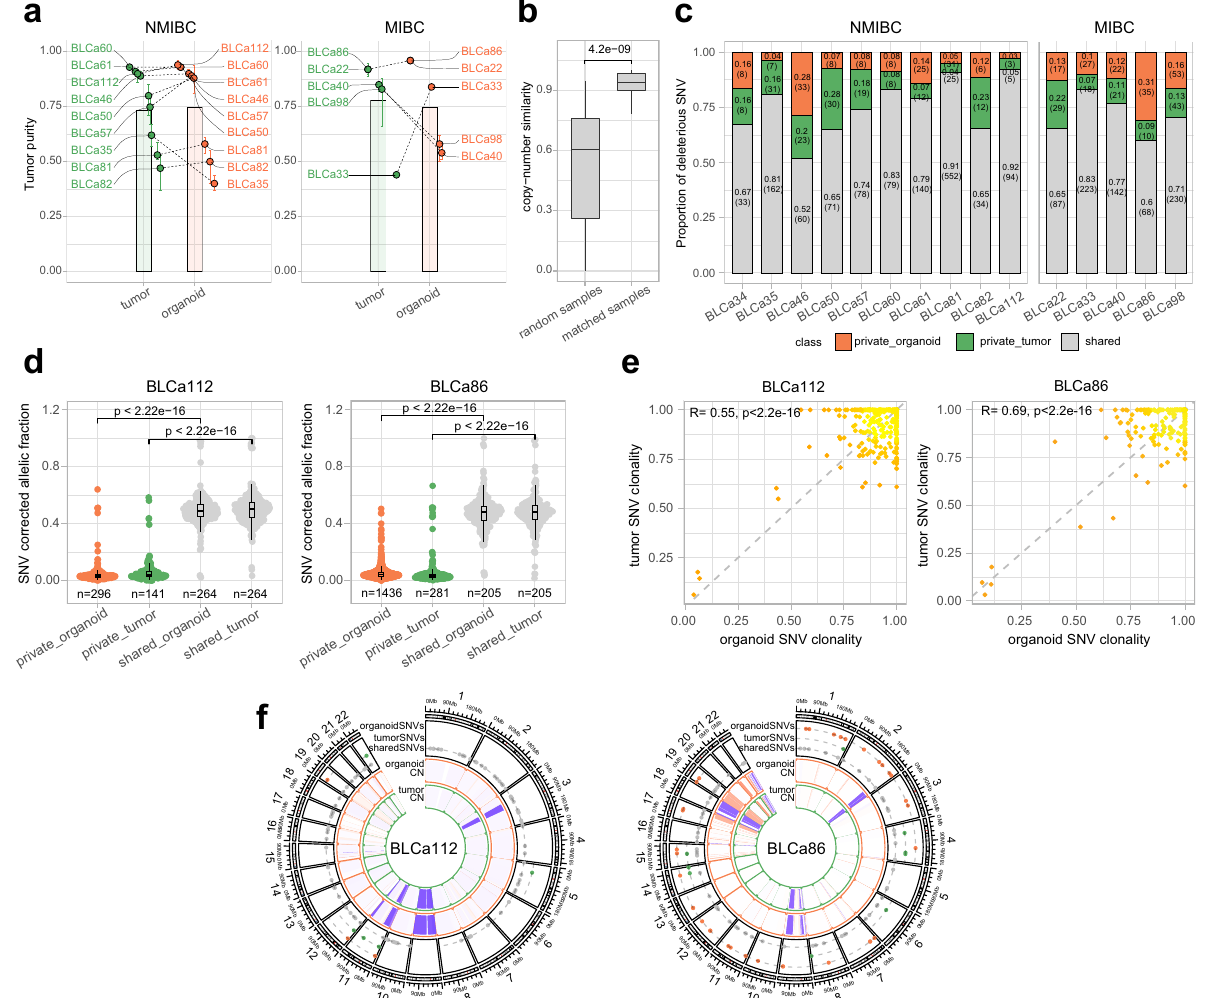
Fig. 3 | Patient-derived organoids (PDOs) retain key genomic features of par- entaltumors(PT).a TumorpurityinPTandmatchedPDOsofnon-muscleinvasive bladder cancer (NMIBC, left) and muscle invasive bladder cancer (MIBC, right) samples ( n =15 biological samples; mean estimate ± SE). Two-sided paired Wil- coxontestbetweenPDOsandPT, p -value=0.31. b Allele-speci fi ccopy-number(CN) similarity in randomly paired samples and matched paired ones ( n =312 randomly matched, n =13 matched PDOs with corresponding PT). Boxplots indicate median (middle line), 25th, 75th percentile (box) and 5th and 95th percentile (whiskers). Two-sided Wilcoxon test, p -value = 4.2e − 09 . c Proportion of shared and private deleterious single nucleotide variants (SNVs) between PDOs and PTs. For each sample, proportions were compared using two-sided Chi-squared test, p -value <0.05. d Distributions of the tumor content and ploidy corrected allelic fraction